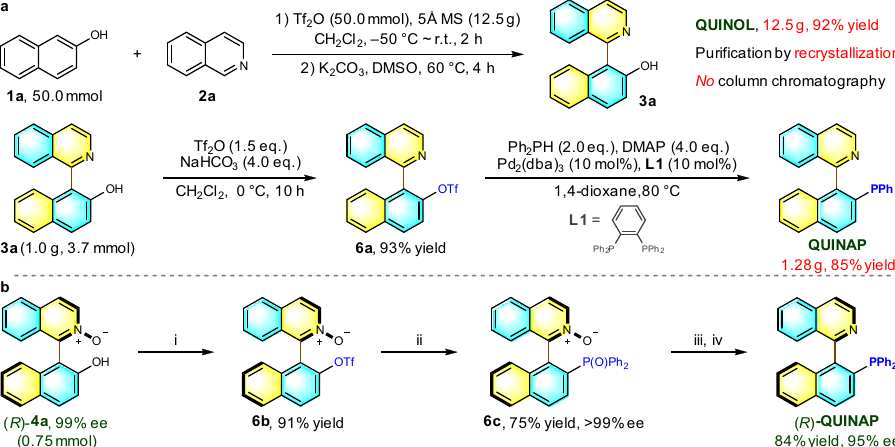
Fig. 6 Preparative synthesis and transformations. a Gram-scale synthesis of ( rac )-QUINOL and ( rac )-QUINAP. b Synthesis of ( R )-QUINAP from ( R )- QUINOL N-oxide. Reaction conditions: i Tf 2 O (1.05 eq.), DMAP (2.0 eq.), CH 2 Cl 2 , r.t., 10h; ii diphenylphosphine oxide (2.0 eq.), Pd(OAc) 2 (12mol%), L1 (24 mol%), DIPEA (5.5 eq.), DMSO, 110°C, 24h; iii bis (pinacolato)diboron (1.0 eq.), diglyme, 70°C, 12h; iv HSiCl 3 (10.0 eq.), DIPEA (40.0 eq.), toluene, 70°C,